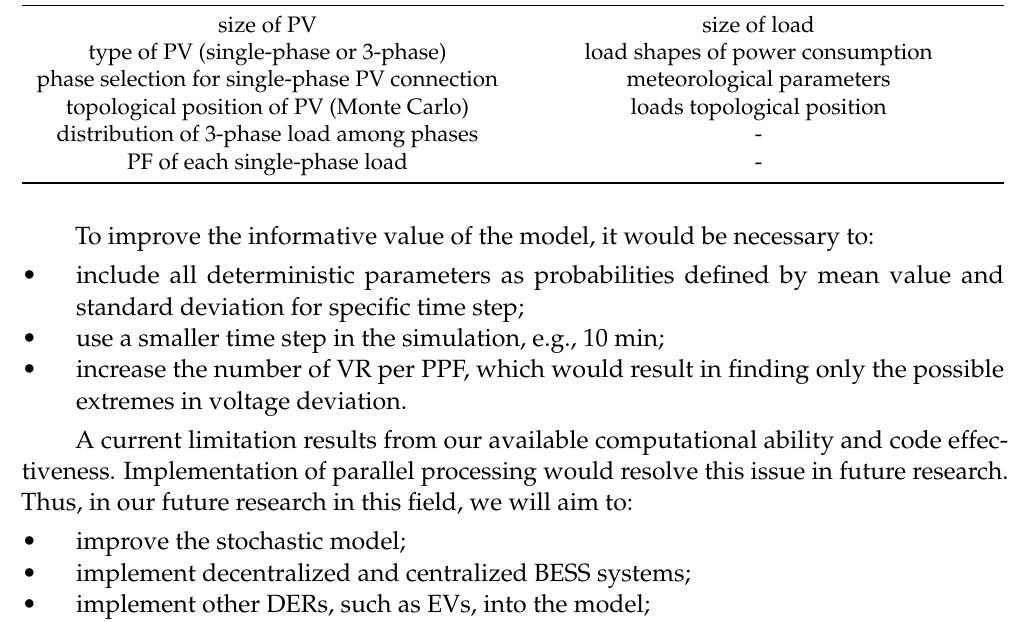
Table 5. Summary of model parameters and their characteristics. Probabilistic